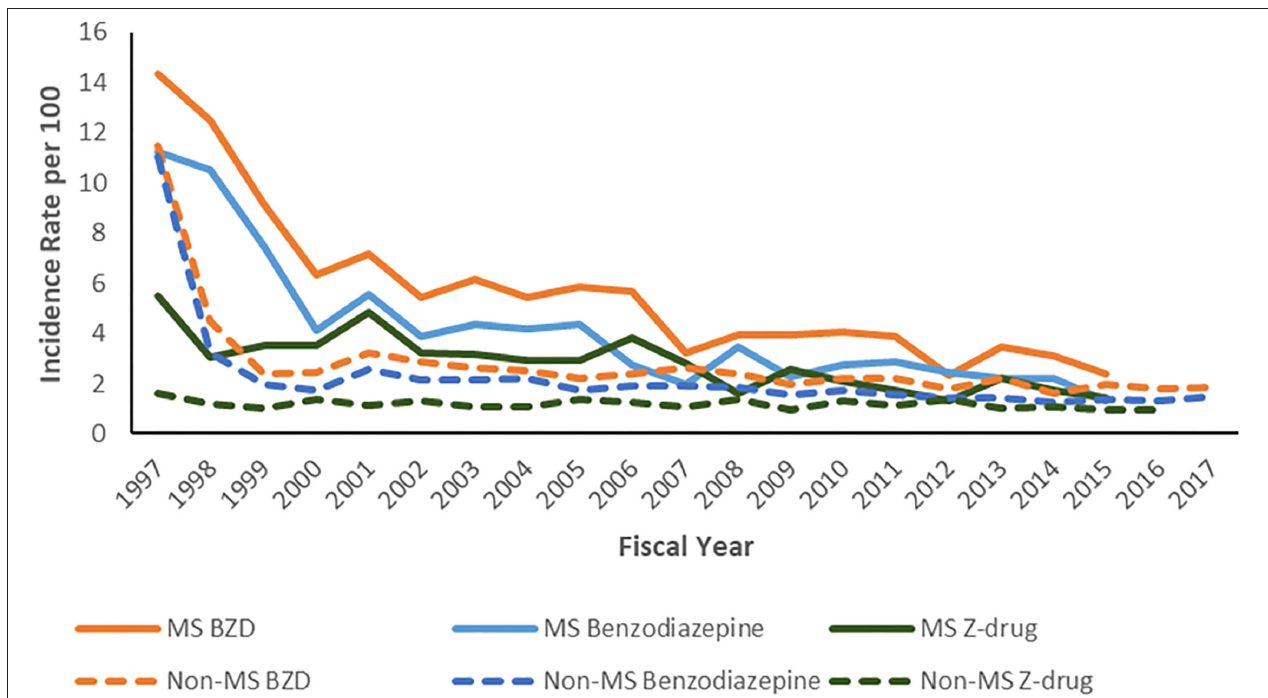
FIGURE 1 | Age- and sex-standardized* annual incidence of benzodiazepine and Z-drug use per 100 persons. *To 2010 Canadian population.